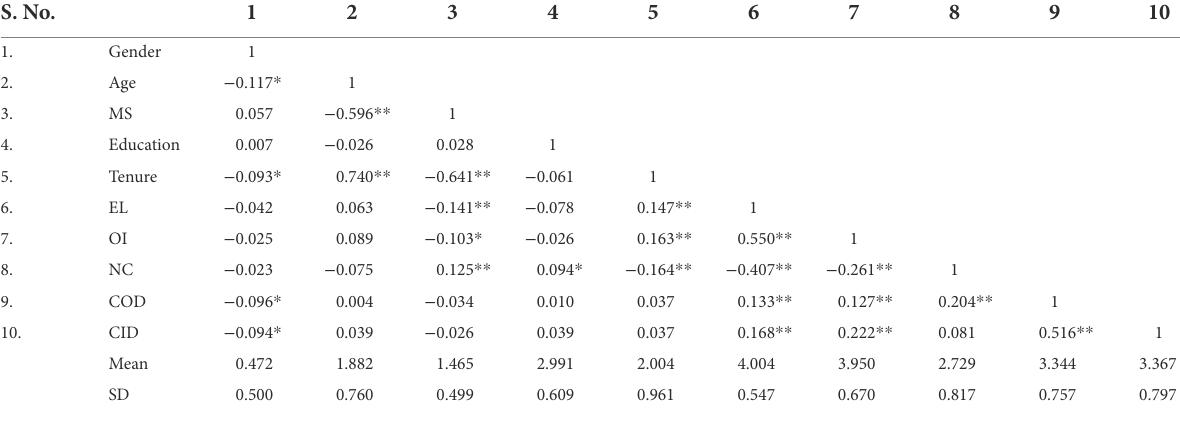
TABLE 2 Means, standard deviations, and correlation coefficients (n = 449). S.